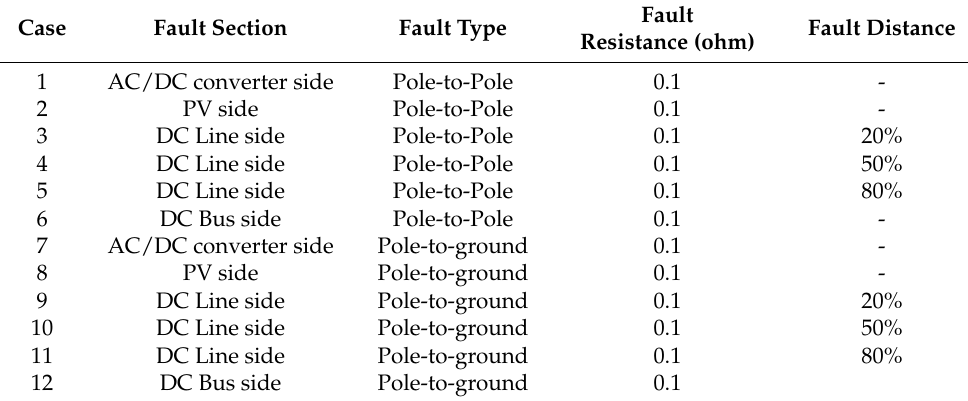
Table 2. Simulation